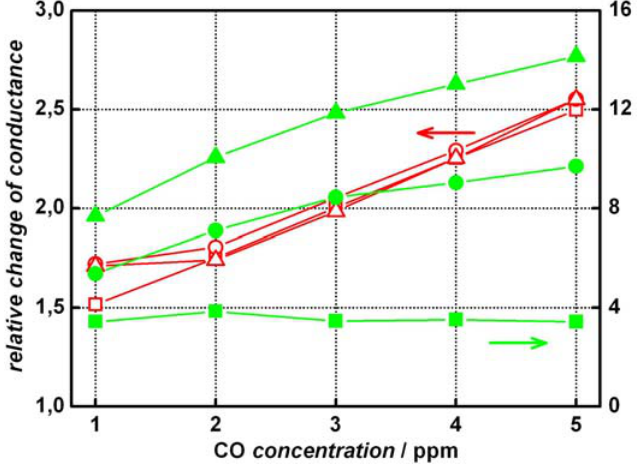
Figure 5. Relative change of conductance for various degrees of humidity: (cid:133) 10%, (cid:123) 50%, ∆ 90%. Hollow red symbols: mesoporous SnO